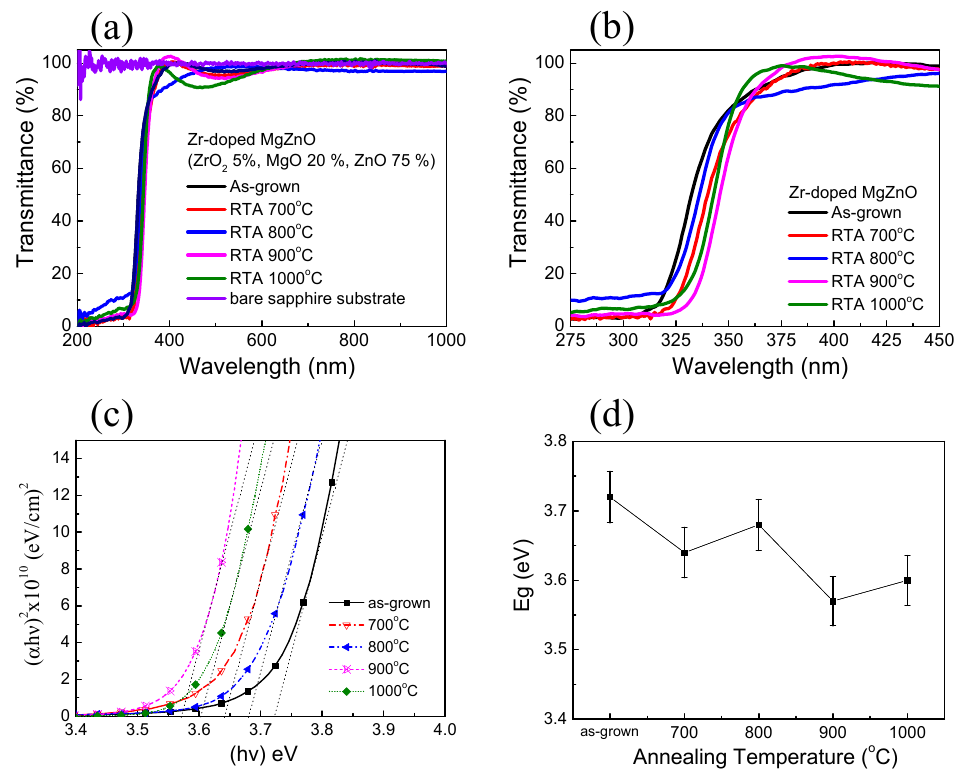
Figure 2. (Color Online) ( a ) Full transmission spectra and ( b ) transmission spectra in the 275–375 nm range of the as-grown and annealed Zr-doped MZO films deposited on sapphire substrates. ( c ) Relationship between ( α h ν ) 2 and photon energy h ν . ( d ) Summary of the E g of the as-deposited and annealed Zr-doped MZO films.